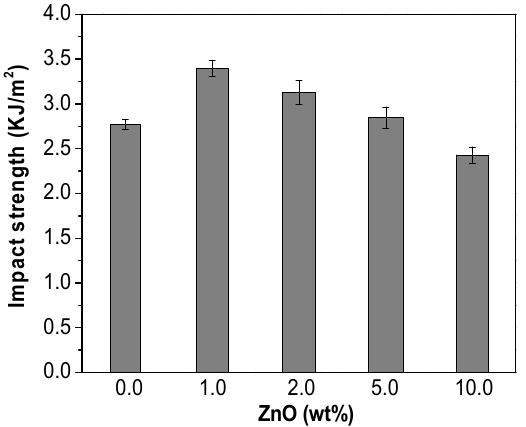
Figure 8. Charpy notched impact strength of PHB and its